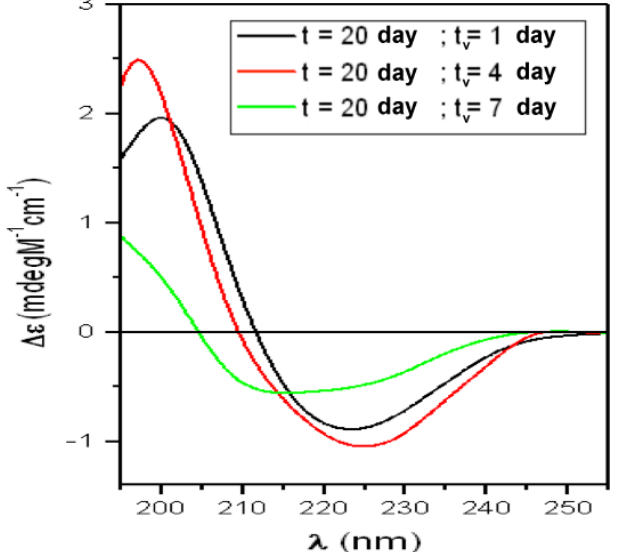
Figure 7. CD spectra relative to the sCT solution representing the “Saturation-phase” (t = 20 days) in the presence of liposomes incorporating GM1 and Chol mimicking “lipid-rafts”. The solution was studied at room temperature and increasing lifespan (tv) Table 4. Percentage of secondary structures obtained by the fitting procedure, relative to spectra of Figure 7.